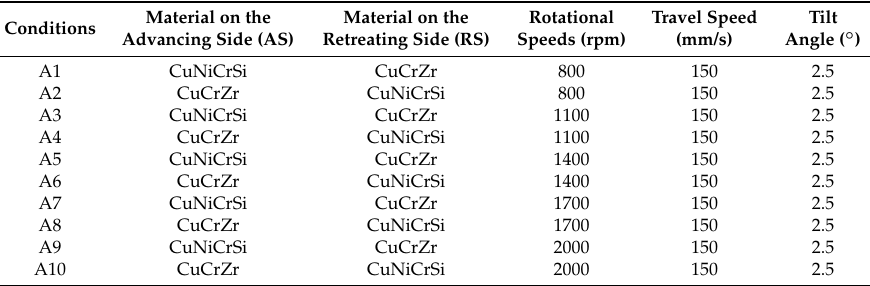
Table 2. The welding parameters used in the